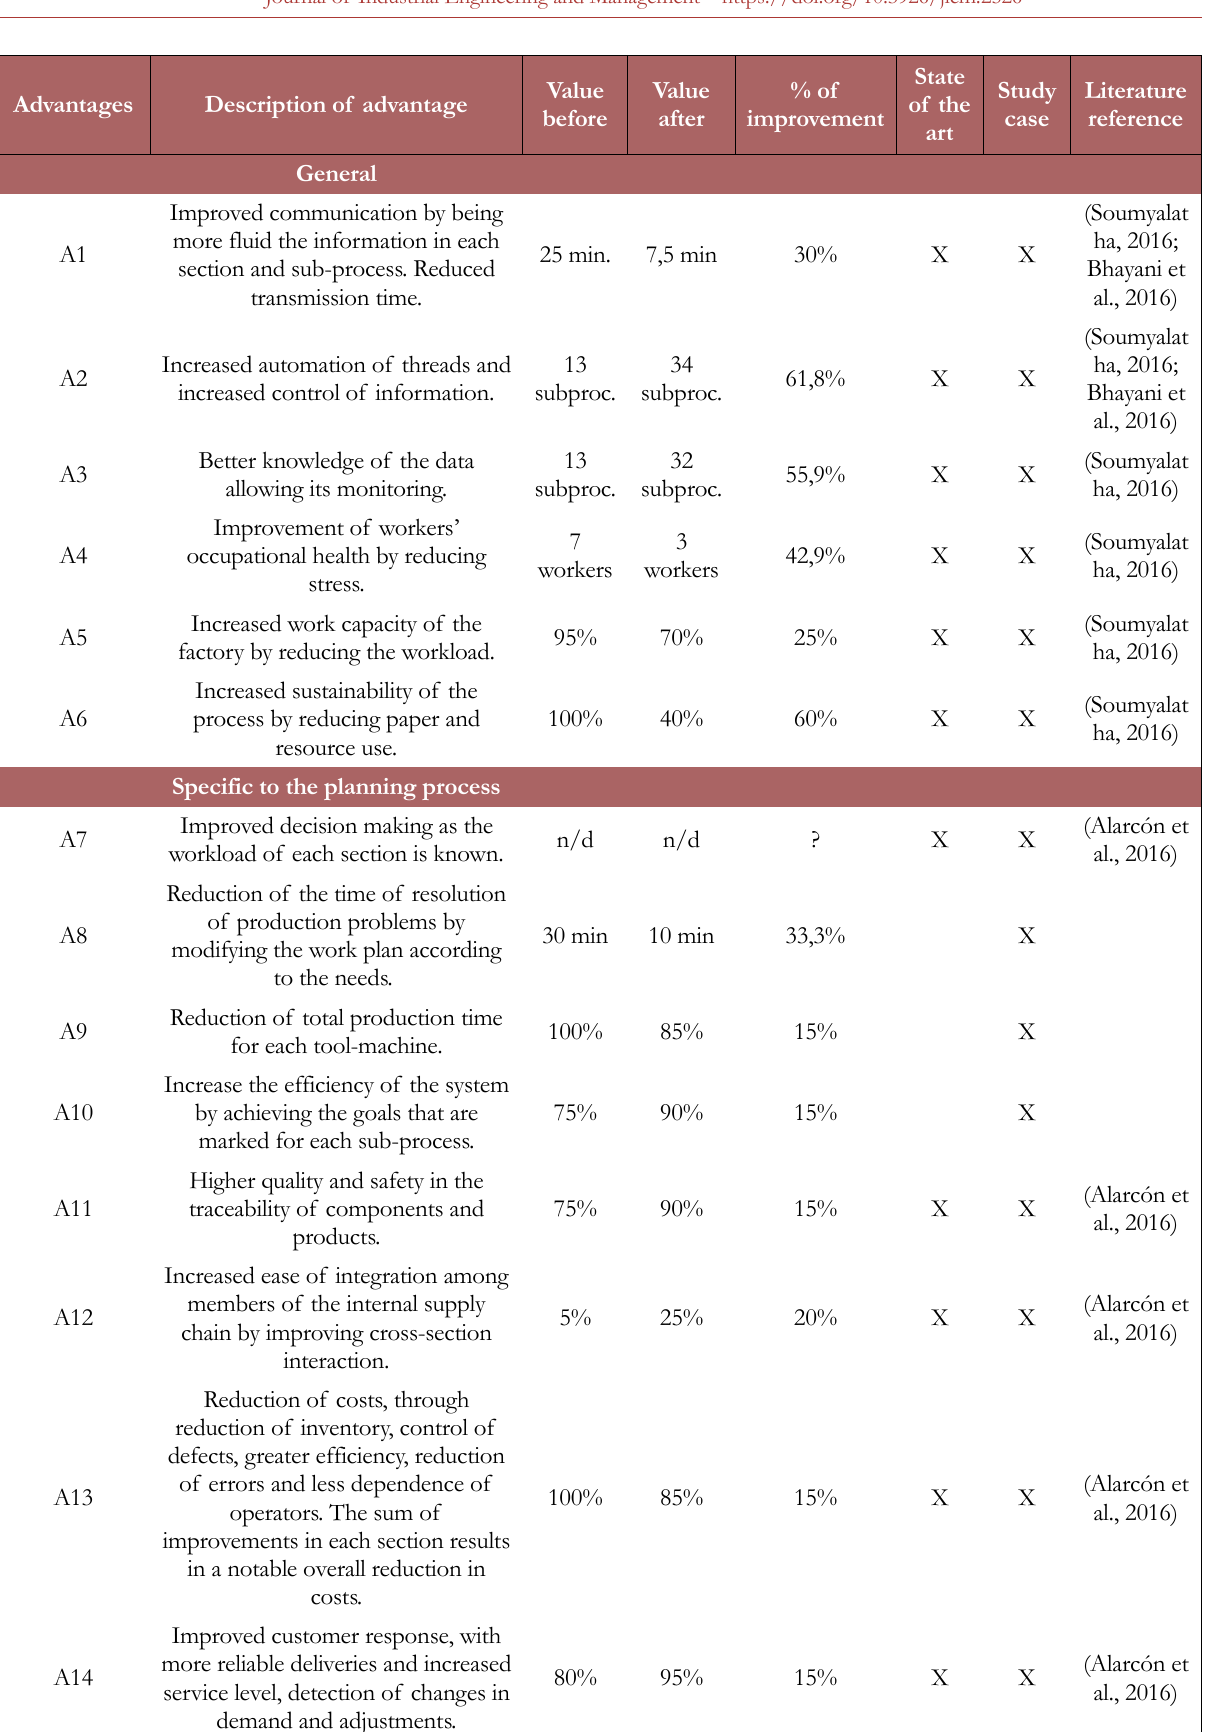
Table 1. General and specific advantages of the IoT in the case